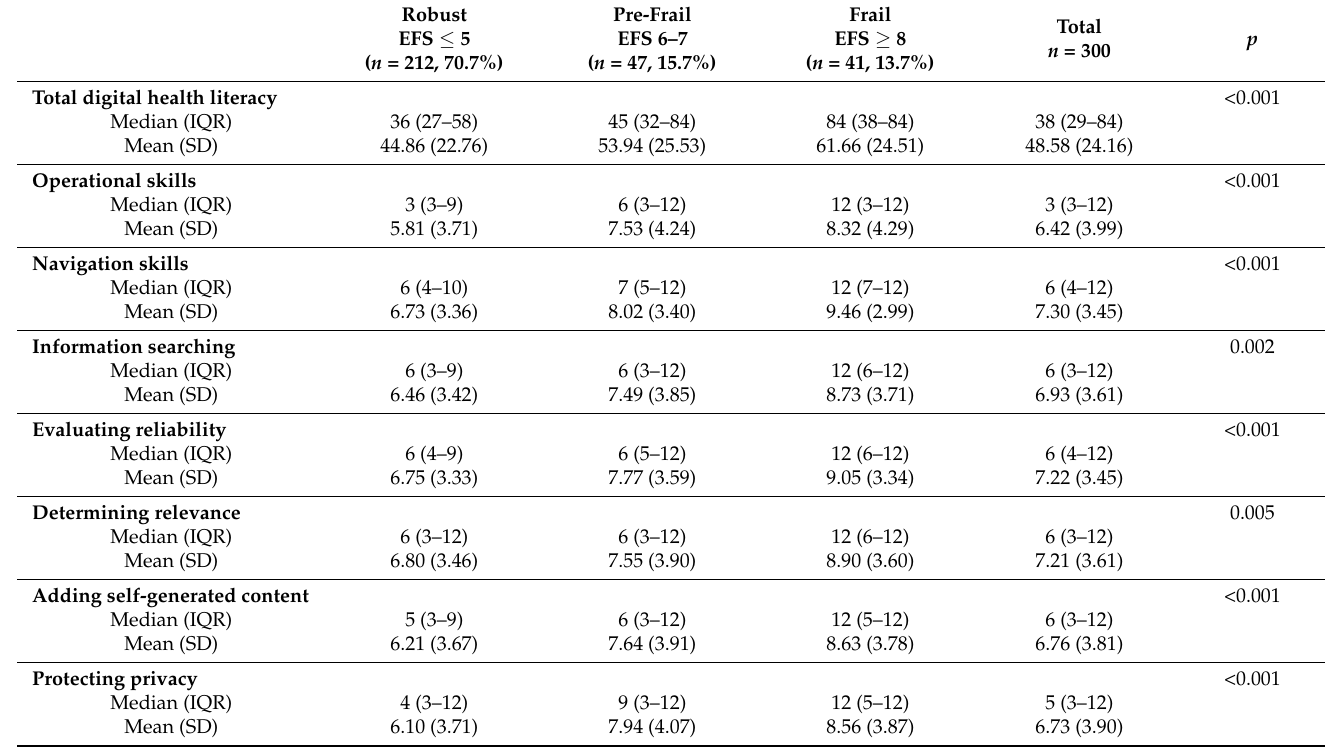
Table 4. Digital Health Literacy Instrument according to frailty